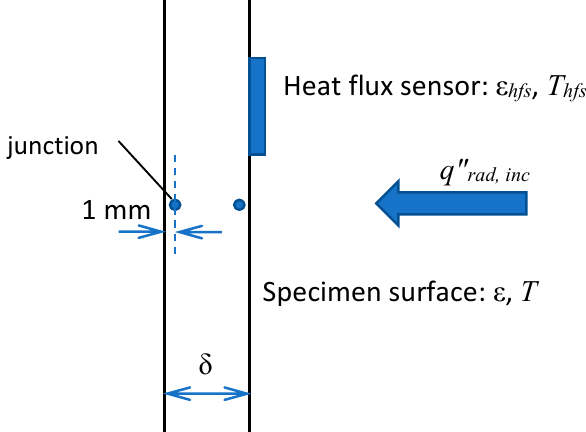
Figure 2. One-sided heating of the sample.